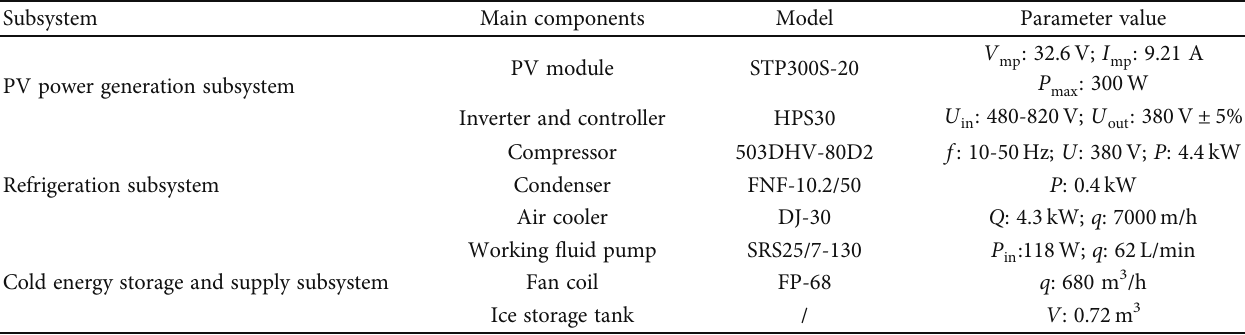
Table 1: Experimental device and its parameters.